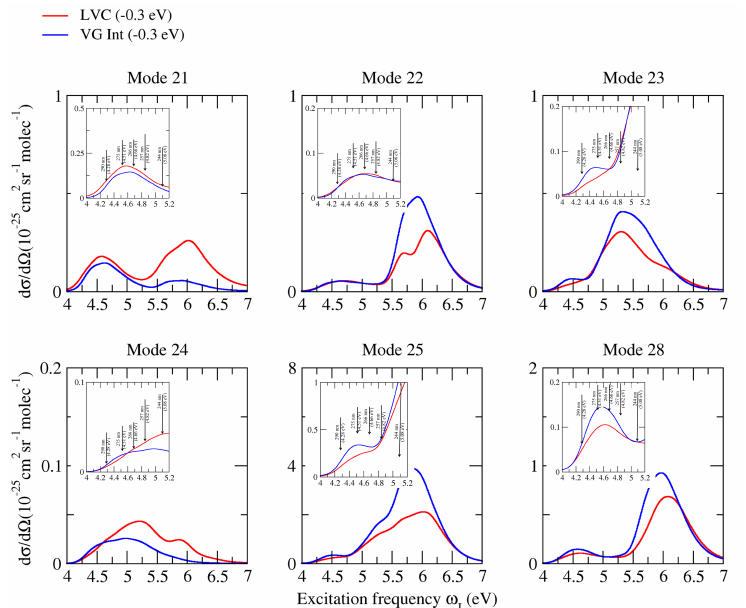
Figure 8. Raman excitation profiles of the four modes of cytosine, computed at non-adiabatic LVC level, and VG Int convoluted with a Lorentzian with damping γ = 0.04 eV and a Gaussian of HWHM = 0.12 eV, calculated by PBE0 and the 6-311G+(d,p) basis sets in